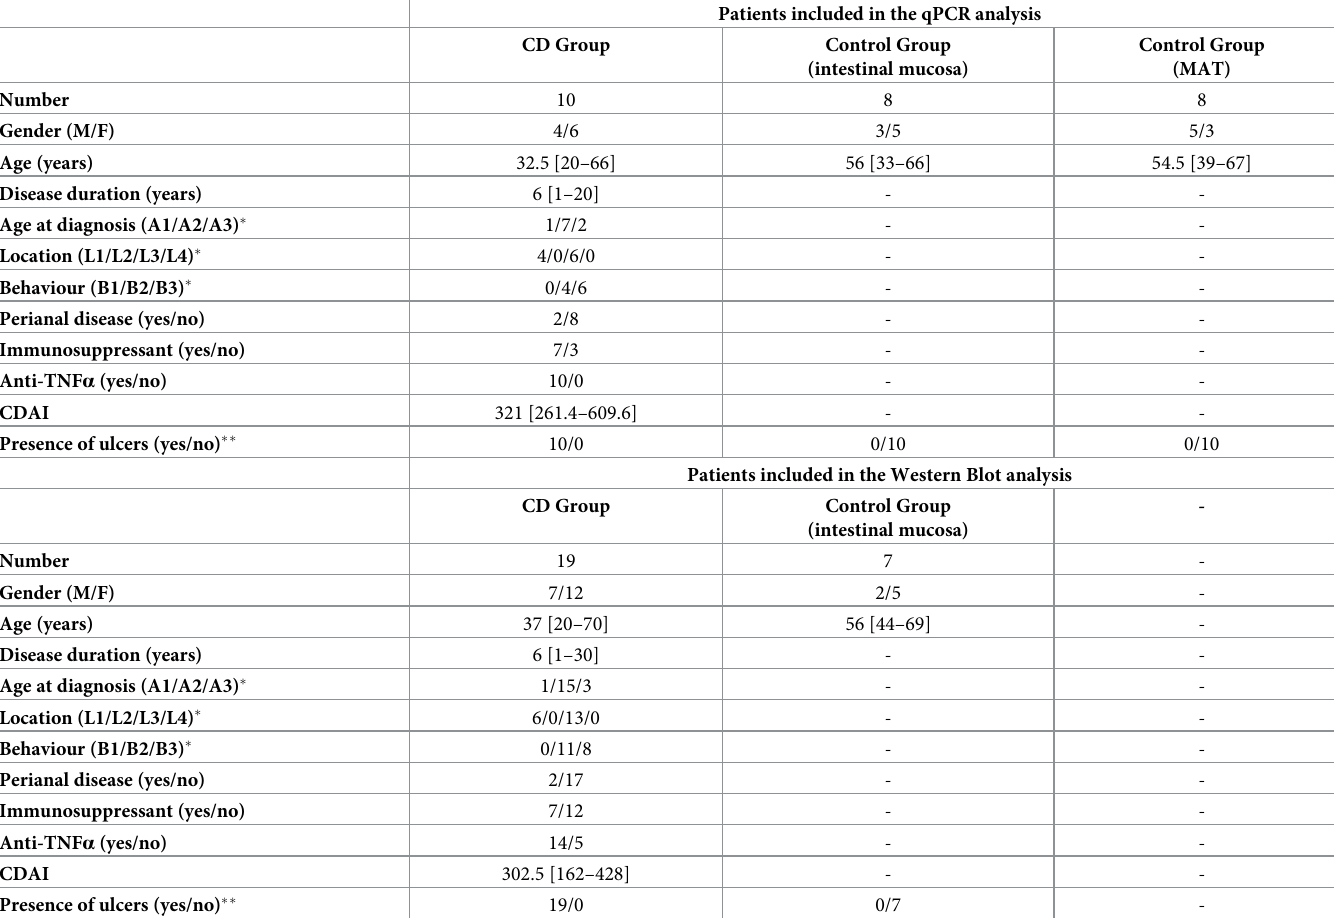
Table 1. Clinical and demographic characteristics of the patients included in the study for the qRT-PCR analysis.